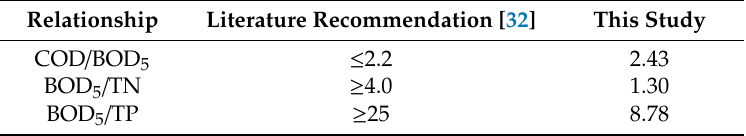
Table 1. Ratios between mean values of selected pollution